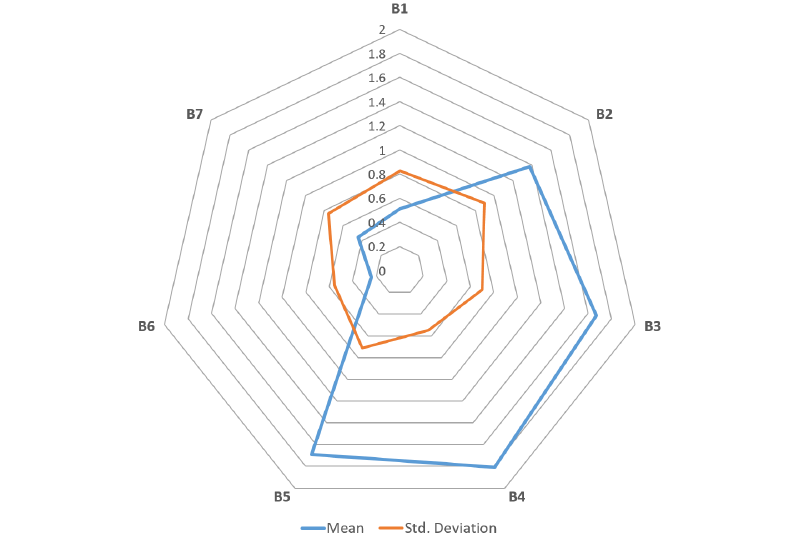
Figure 3. Mean and standard deviation of belongings and assets of the